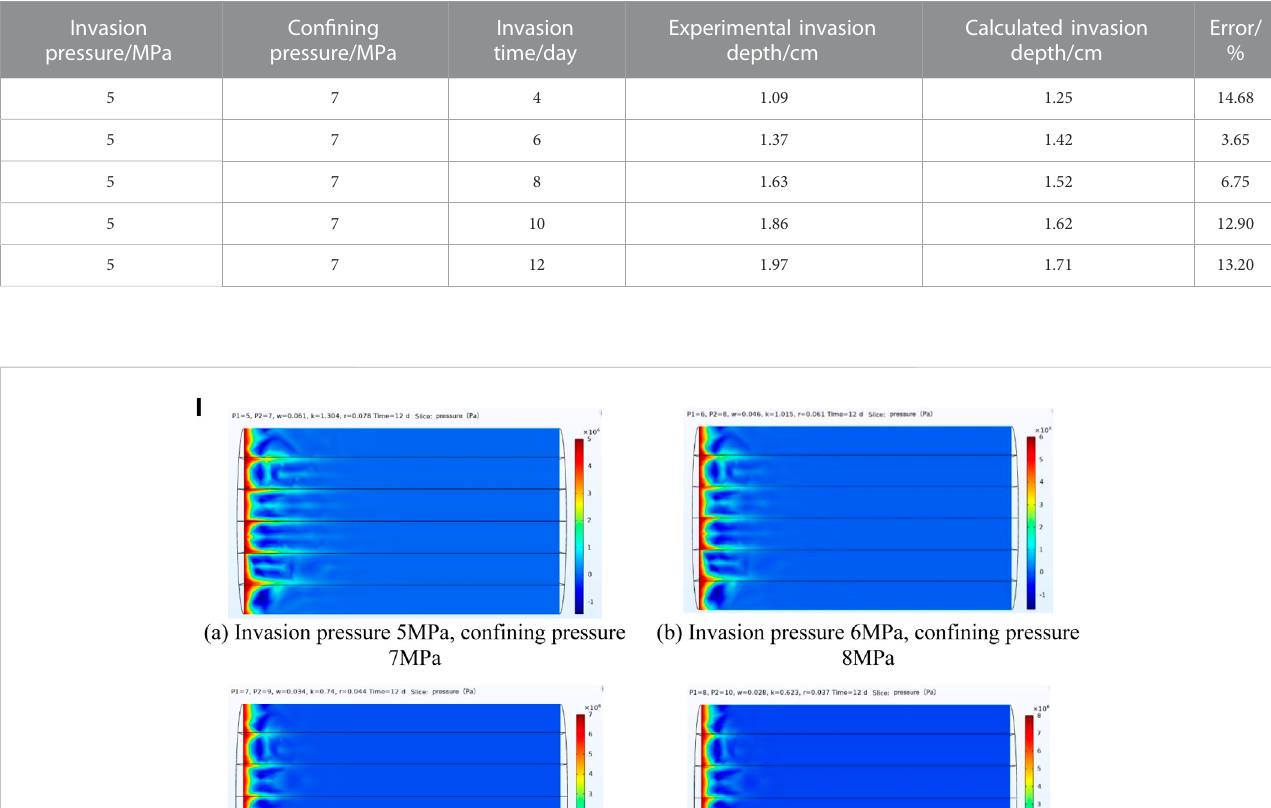
TABLE 3 Calculated and experimental values of invasion depth under different invasion times.